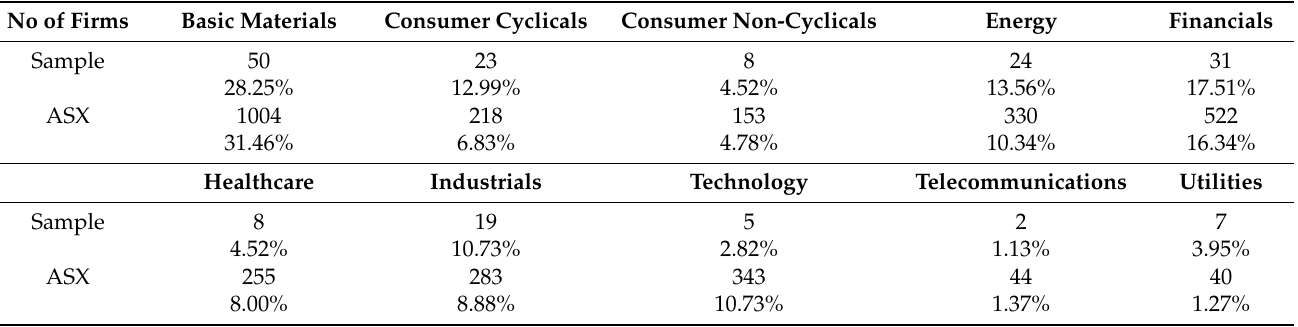
Table 2. Distribution of firms by